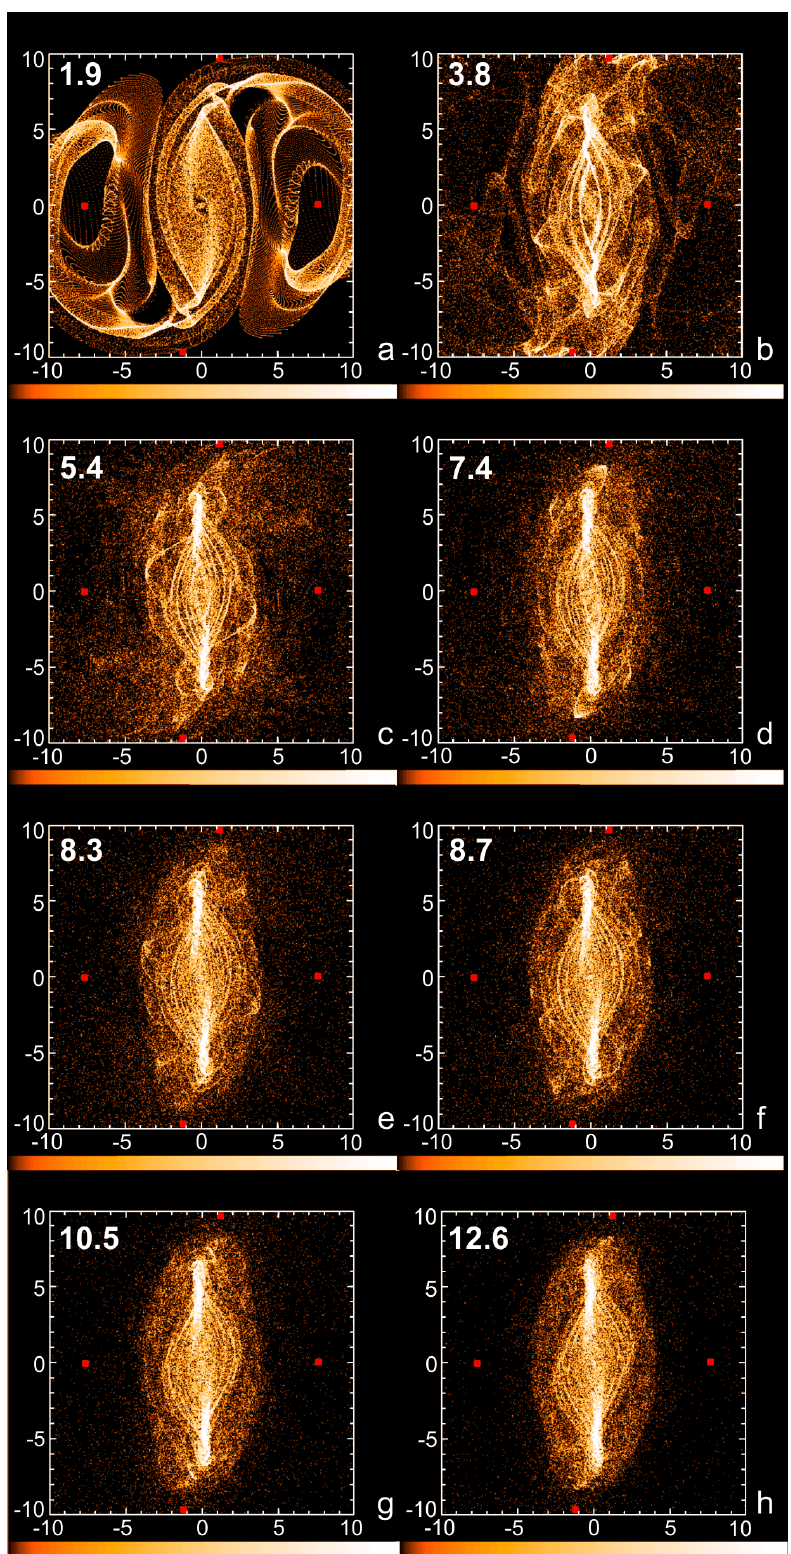
Figure 2. ( a – h ) Successive snapshots of the stellar response model. Lighter regions correspond to denser regions, according to the logarithmic color bar at the bottom of the panels. The number of pattern rotations is given at the upper-left corner of the frames. The red dots indicate the location of L 1 ( top ), L 2 ( bottom ), L 4 ( right ) and L 5 ( left ) of the bar. The bar rotates